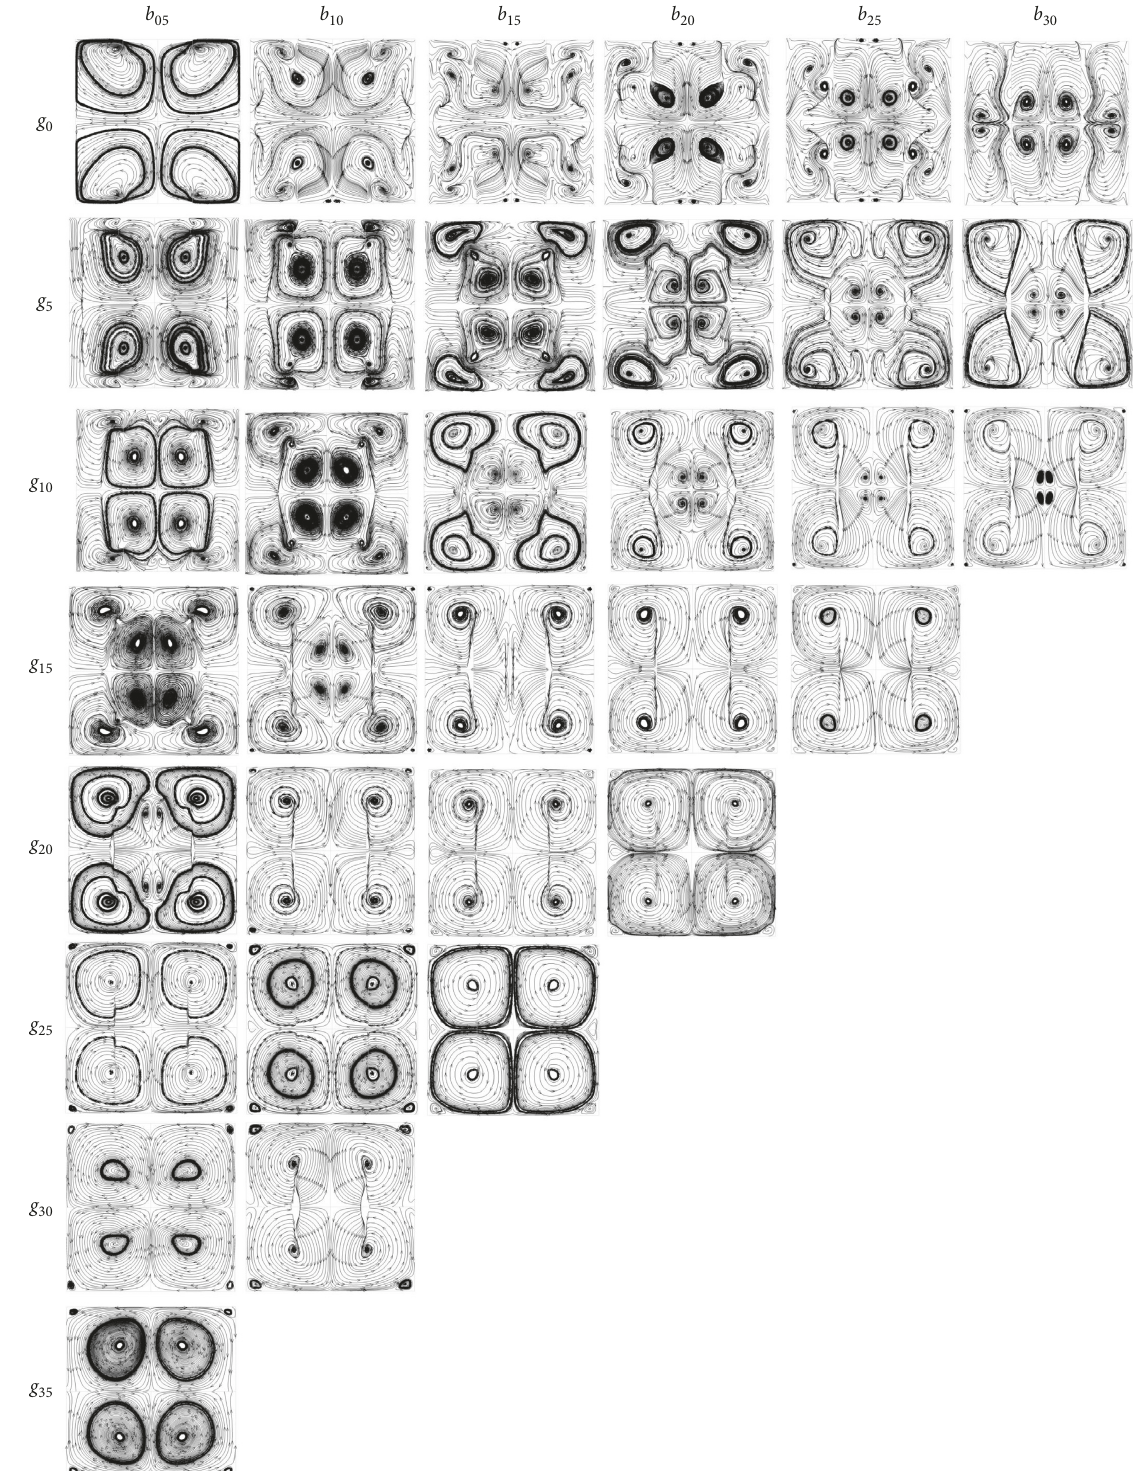
Figure 3: Streamlines in transverse planes for the square channel heat exchanger installed with V-orifice at various blockage ratios and gap spacing ratios for Re � 800 and V-downstream